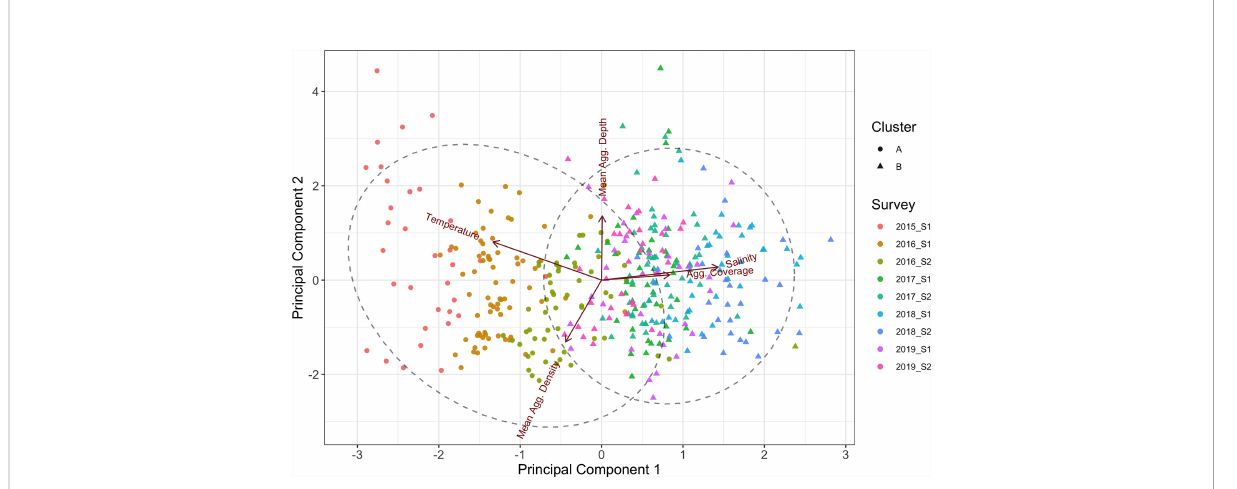
FIGURE 6 Results of the K-means clustering applied to the principal component analysis of the CTD and acoustic aggregation data plotted against the 1st and 2nd principal components. Clusters are differentiated as circles and triangles and colured by survey ID. The dashed lines represent the 95% normal-probability contour of each